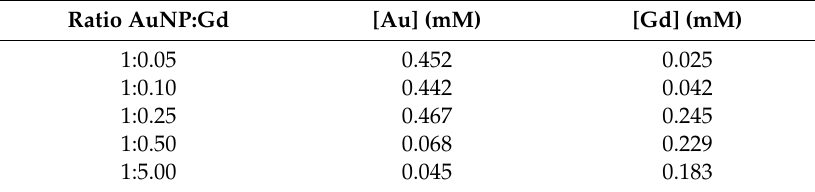
Table 1. Gd and Au content of the NP corresponding to di ff erent complexation ratios, measured by ICP-OES. Ratio AuNP:Gd